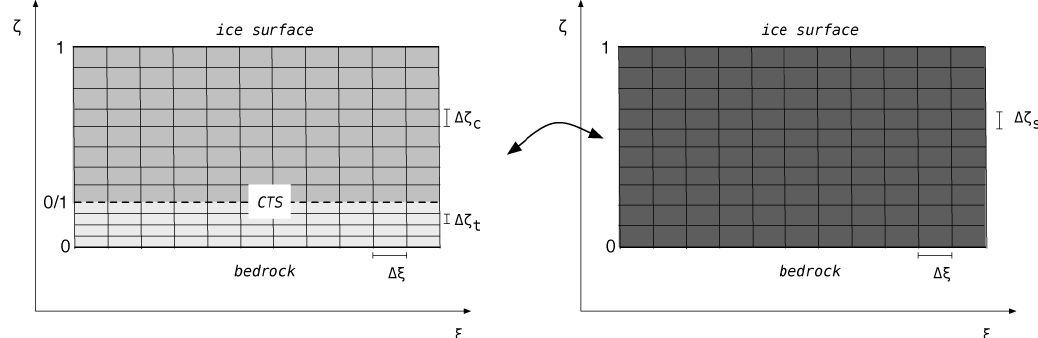
Figure 4. Semi-Lagrangian sigma-transformed grid. The original cold and temperate grid on the left are both covered by the semi-Lagrangian grid.